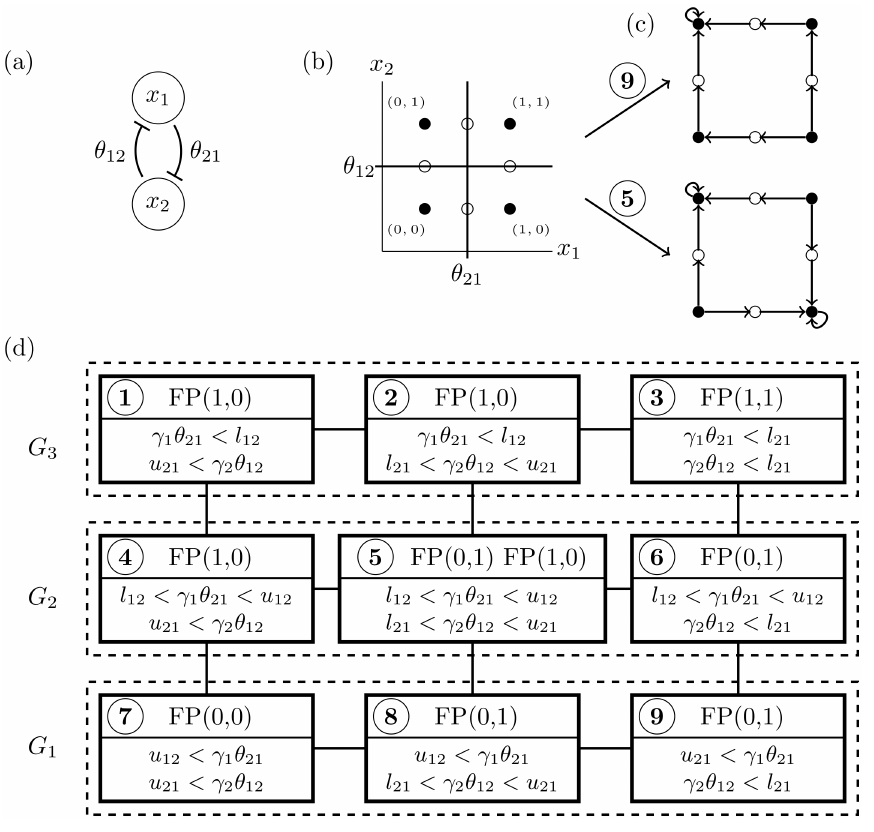
Fig 2. DSGRN for toggle switch. (a) Regulatory network for the toggle switch. (b) Thresholds { θ 2,1 , θ 1,2 } divide phase space, (0, 1 ) 2 , into four 2-dimensional domains (black dots) and 1-dimensional walls separating the domains (circles). (c) For each choice of parameters, given a domain there is a well-defined direction of dynamics at walls that defines the state transition graph (see Fig 6 for the derivation of this dynamics). State transition graph for parameters in regions 5 and 9 of the parameter graph. The Morse graph for 9 consists of a single node FP(0, 1) where FP indicates that the node is terminal in the Morse graph (a trivial statement for this simple example) and that the vector representation of the associated region is (0, 1). The Morse graph for 5 contains two nodes FP(0, 1) and FP(1, 0). (d) Visual interpretation of SQL DSRGN database for toggle switch organized as a parameter graph with explicit description of parameter domains (inequalities in bottom of each square) and Morse graphs (top part of each square) valid over corresponding parameter domain. Dashed boxes indicate elements of PG ( ¬ 1)= { G 1 , G 2 , G 3 }.